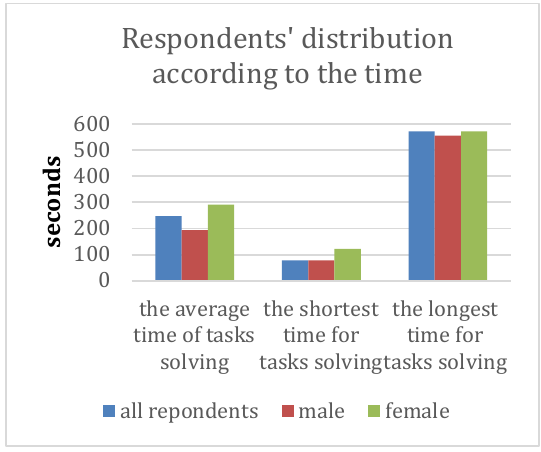
Fig. 6 Distribution of respondents according to the time of solving tasks in